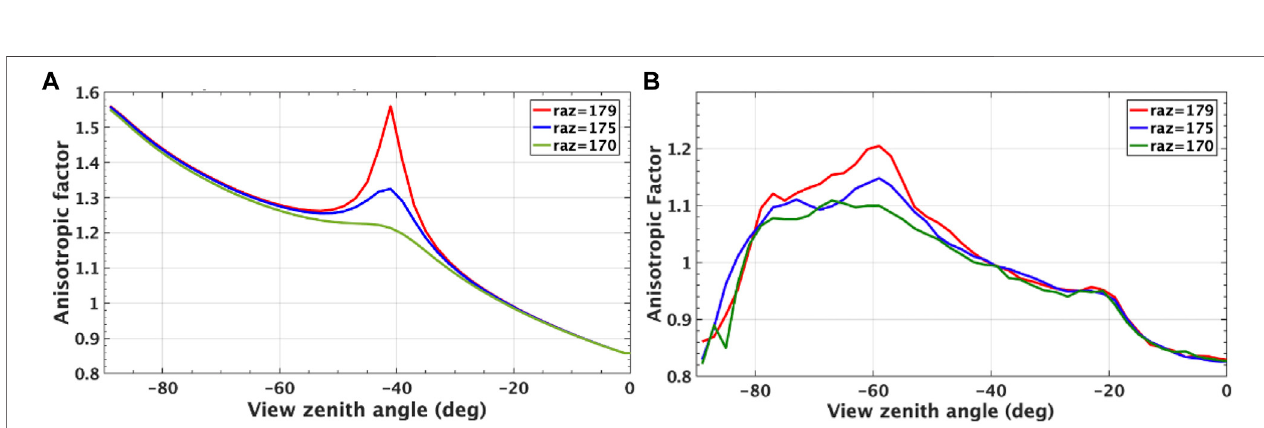
FIGURE 8 | Anisotropic factors at near-backscattering directions for relative azimuth angle of 179 ◦ (red), 175 ◦ (blue), and 170 ◦ (green) for (A) clear cropland in December with solar zenith angle of 40 ◦ and (B) for liquid clouds ( ln ( f τ ) (cid:1) 8) over ocean with solar zenith angle of 60 ◦ .